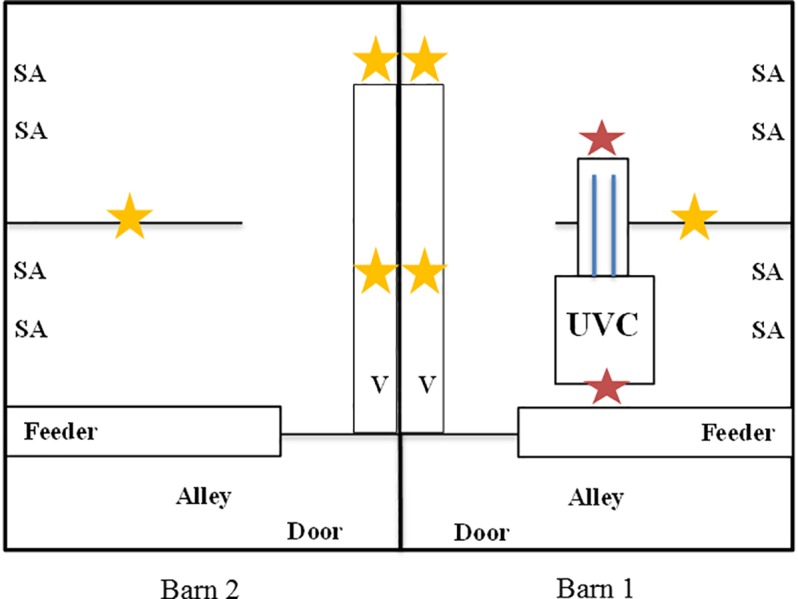
Structure of the barns and sampling points.Stars in yellow indicate the sampling locations for airborne dust and bacteria. Measures taken in front of and behind the UVC module are given as light red stars. SA–inlet valves for supply air; UVC–position of the UVC module; V–position of exhaust air vents.